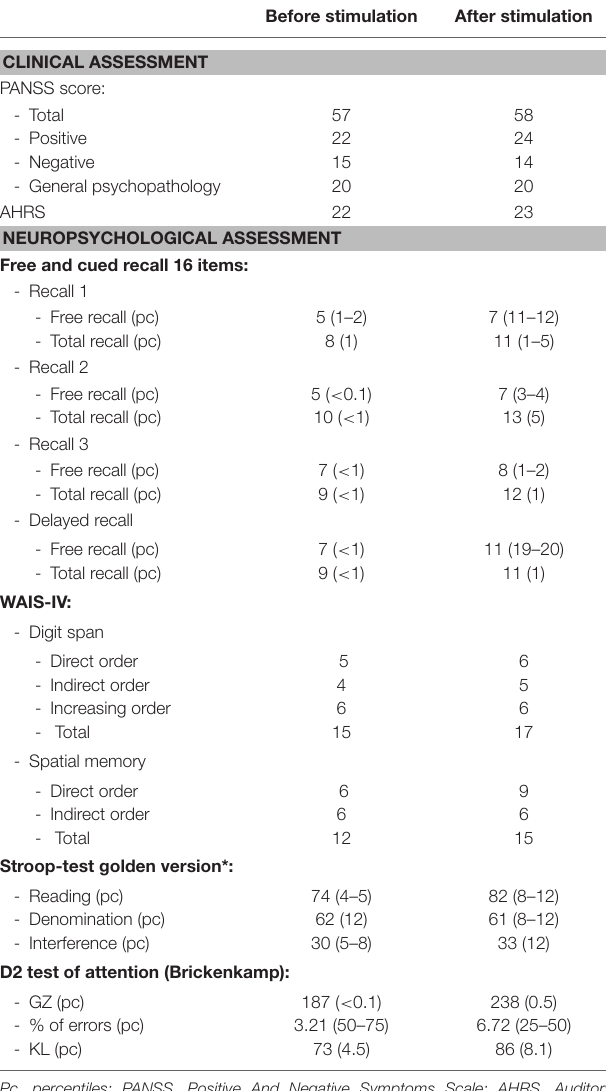
TABLE 1 | Clinical and neuropsychological characteristics before and after cerebellar stimulation. Before